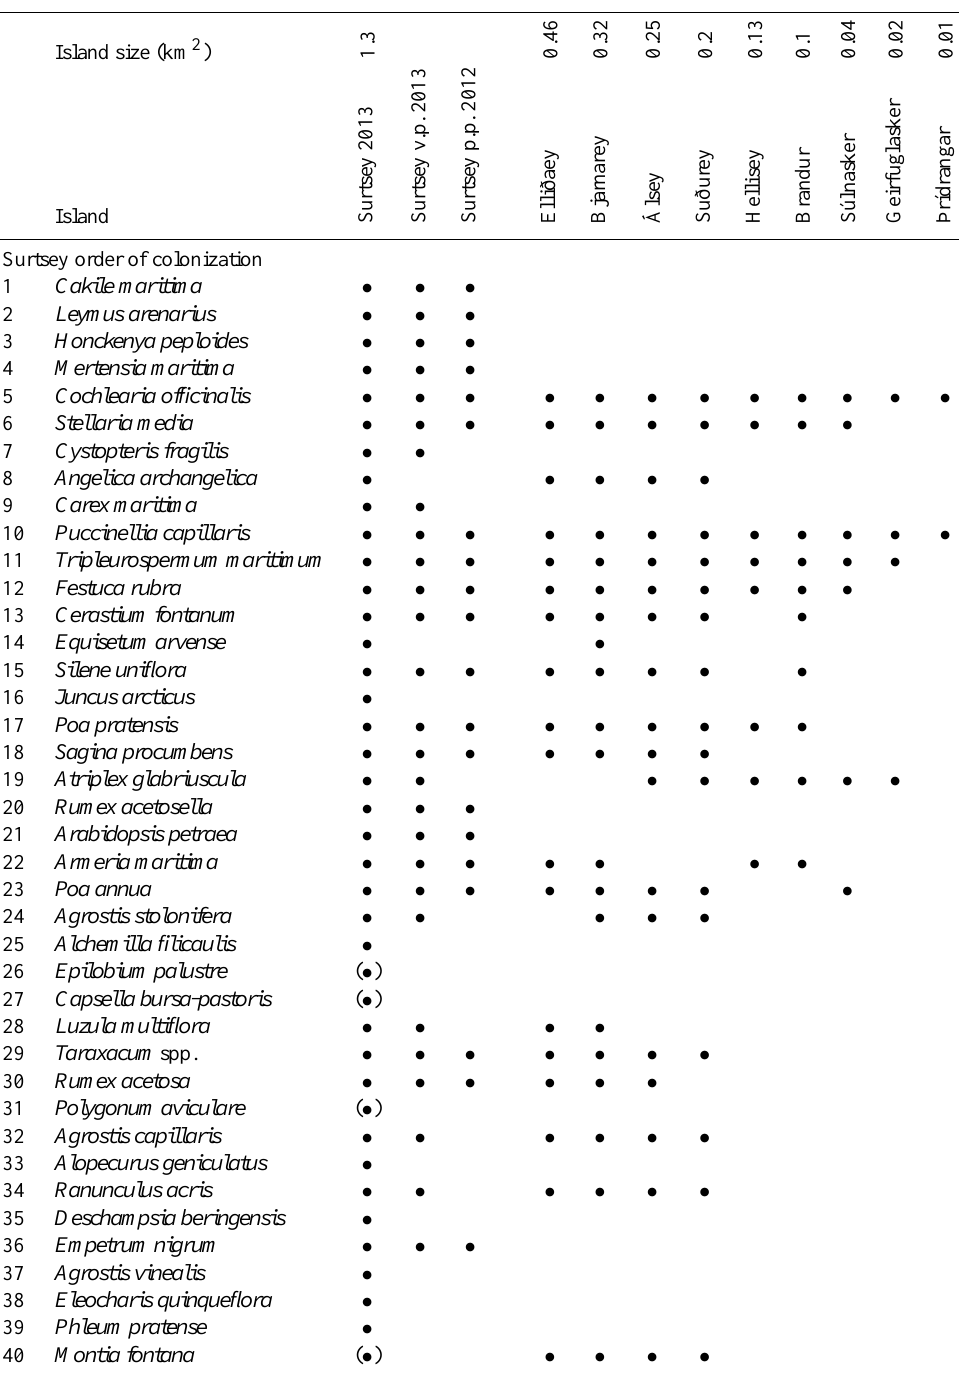
Table A1. Vascular plants colonizing Surtsey during the period 1965–2013 and species list for neighbouring Vestmannaeyjar islands; ( • ) denotes species that have been recorded on Surtsey but were not present in 2013; species that had formed viable populations (v.p.) in 2013 or were found within permanent plots (p.p) in 2012 are marked. The species list of the Vestmannaeyjar islands is based on Friðriksson and Johnsen 1967, and our surveys of Elliðaey and Álsey in